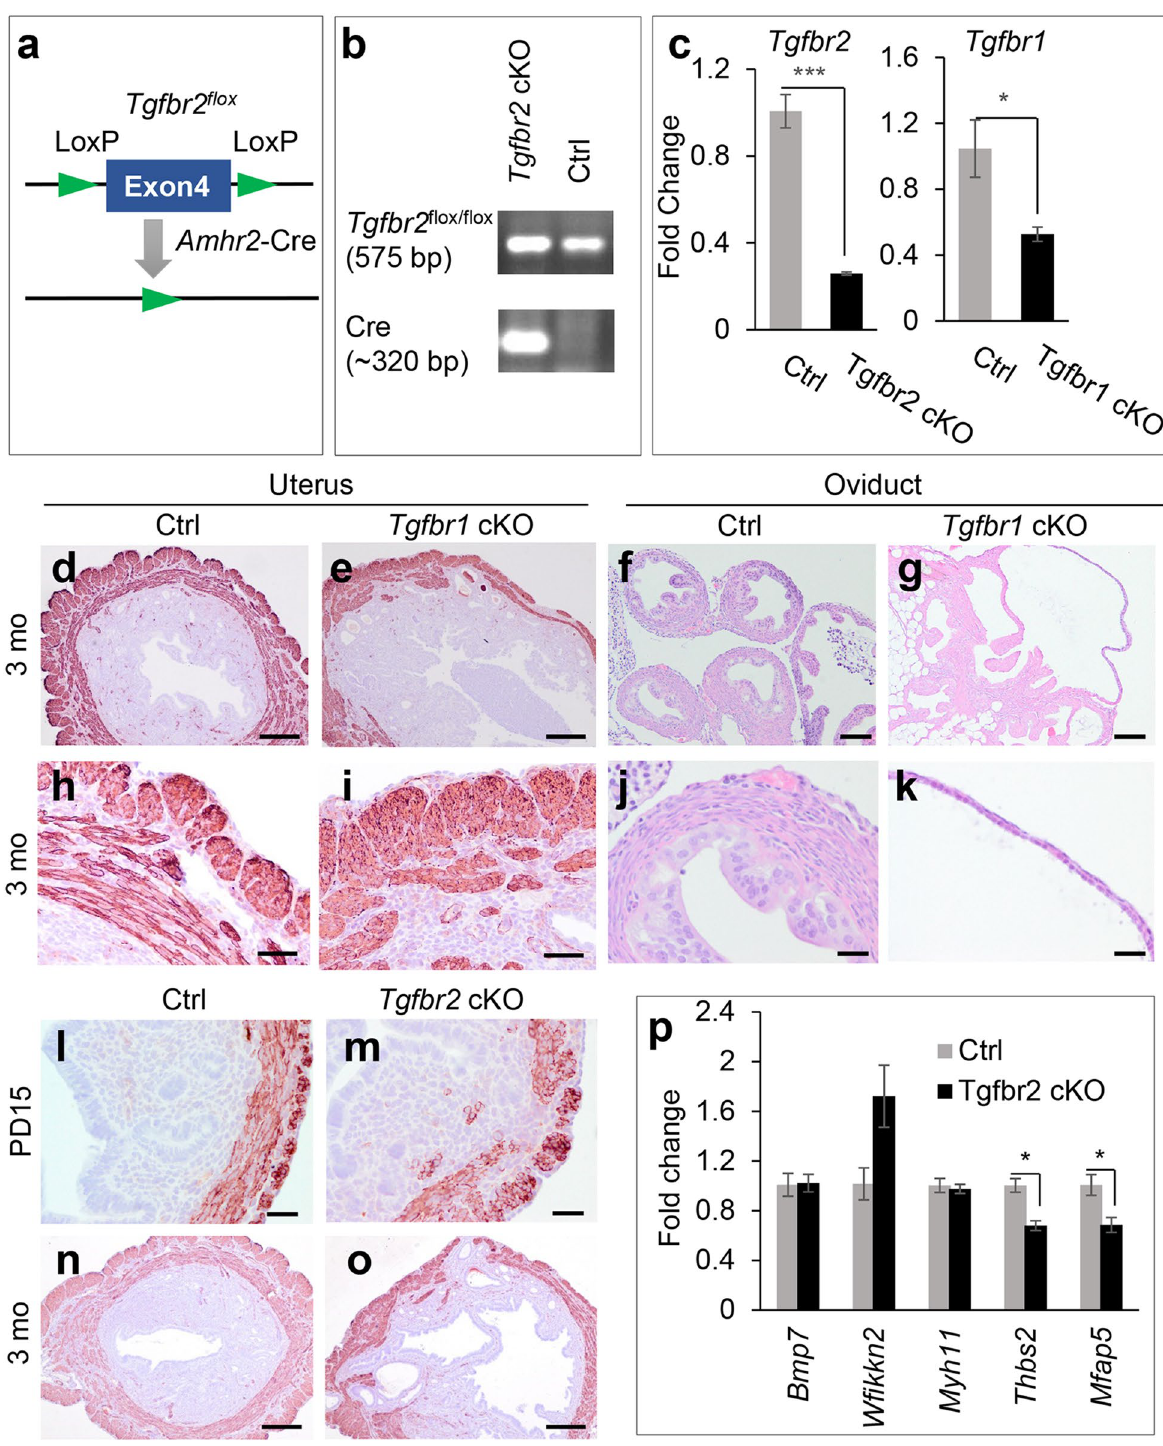
Figure 1. Loss of TGFBR2 disrupts myometrial formation. ( a ) Schematic representation of Cre-LoxP deletion of Tgfbr2 . ( b ) Representative genotyping to identify Tgfbr2 cKO and control mice. The full gel image is shown in Supplementary Fig. S1. ( c ) Reduced mRNA levels of Tgfbr2 and Tgfbr1 in the uteri of Tgfbr2 cKO and Tgfbr1 cKO at PD15, respectively. n = 3–4. * P < 0.05, *** P < 0.001. ( d–k ) Immunostaining of ACTA2 in the uteri and H.E. staining of oviducts using controls and Tgfbr1 cKO at 3 months of age. ( h – k ) Represent higher magnification images for ( d – g ). ( l–o ) Immunostaining of ACTA2 in the uteri of controls and Tgfbr2 cKO at PD15 and 3 months. Three independent mice were used for each genotype. ( p ) Transcript levels of Bmp7, Wfikkn2, Myh11, Thbs2 , and Mfap5 in the uteri of controls and Tgfbr2 cKO at PD15. n = 3. * P < 0.05. Scale bar equals 25 µm ( j , k , l , m ), 50 µm ( h , i ), 100 µm ( f , g ), and 250 µm ( d , e , n , o